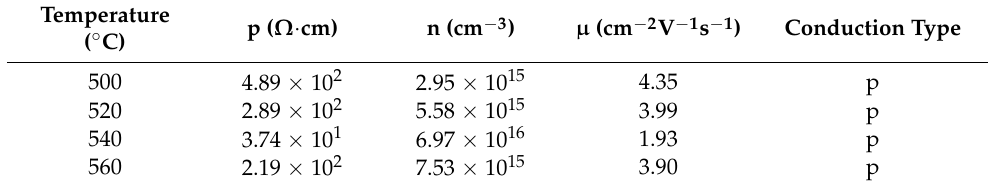
Table 2. Electrical properties of the CMZTSSe films annealed at different temperatures from 520 to 560 °C.